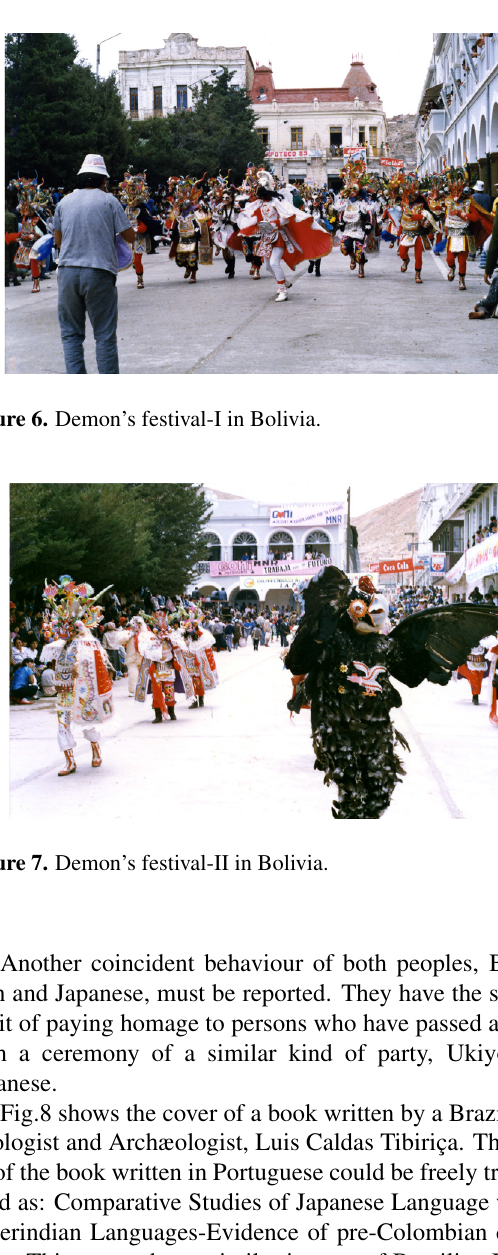
Figure 4. Nusex experiment.